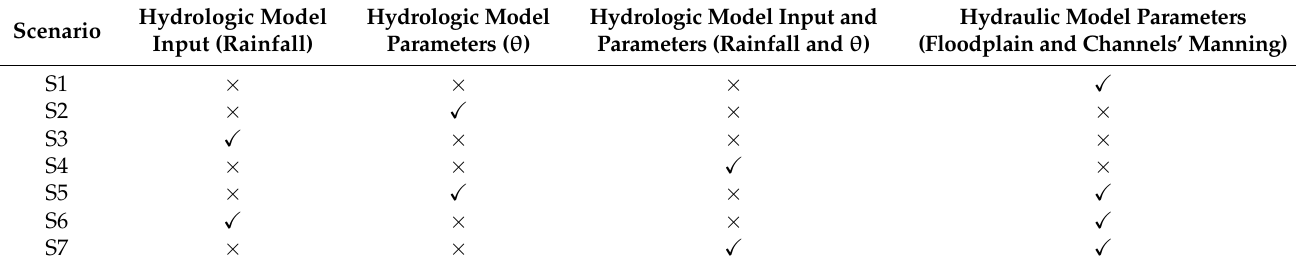
Table 4. Scenarios to incorporate uncertainty in hydrologic and hydraulic